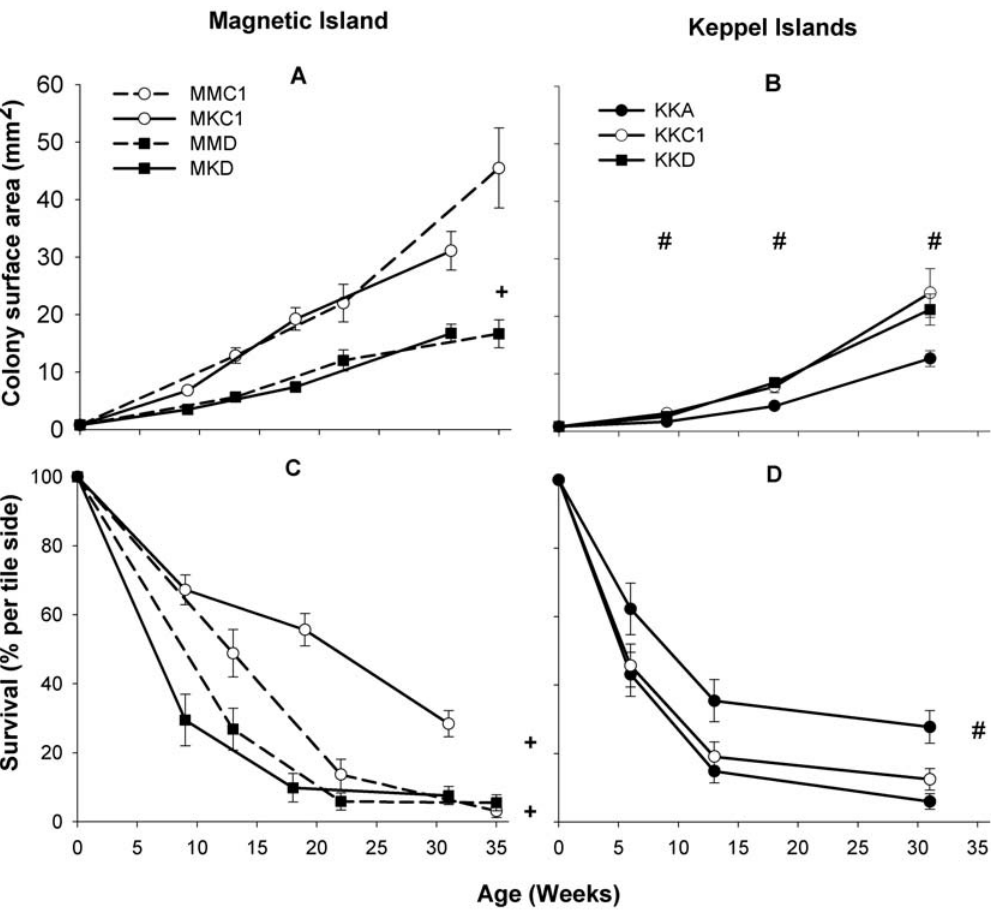
Figure 1. Growth and survival of coral juveniles at Magnetic Island (a + c) and the Keppel Islands (b + d). See materials and methods for nomenclature of the experimental groups. + indicates significant difference between juvenile corals harboring Symbiodinium C1 and those harboring D (p , 0.05), and # indicates significant difference between KKA and KKC1/KKD corals (growth, p , 0.05) or between KKD and KKA/KKC1 corals (survival, p , 0.001). C1 corals grew and survived better at Magnetic Island than the D corals. At the Keppel Islands, KKC1 and KKD corals grew at similar rates, but KKD corals had a better survival rate. KKA corals grew slowest at the Keppel Islands and had a low survival rate.